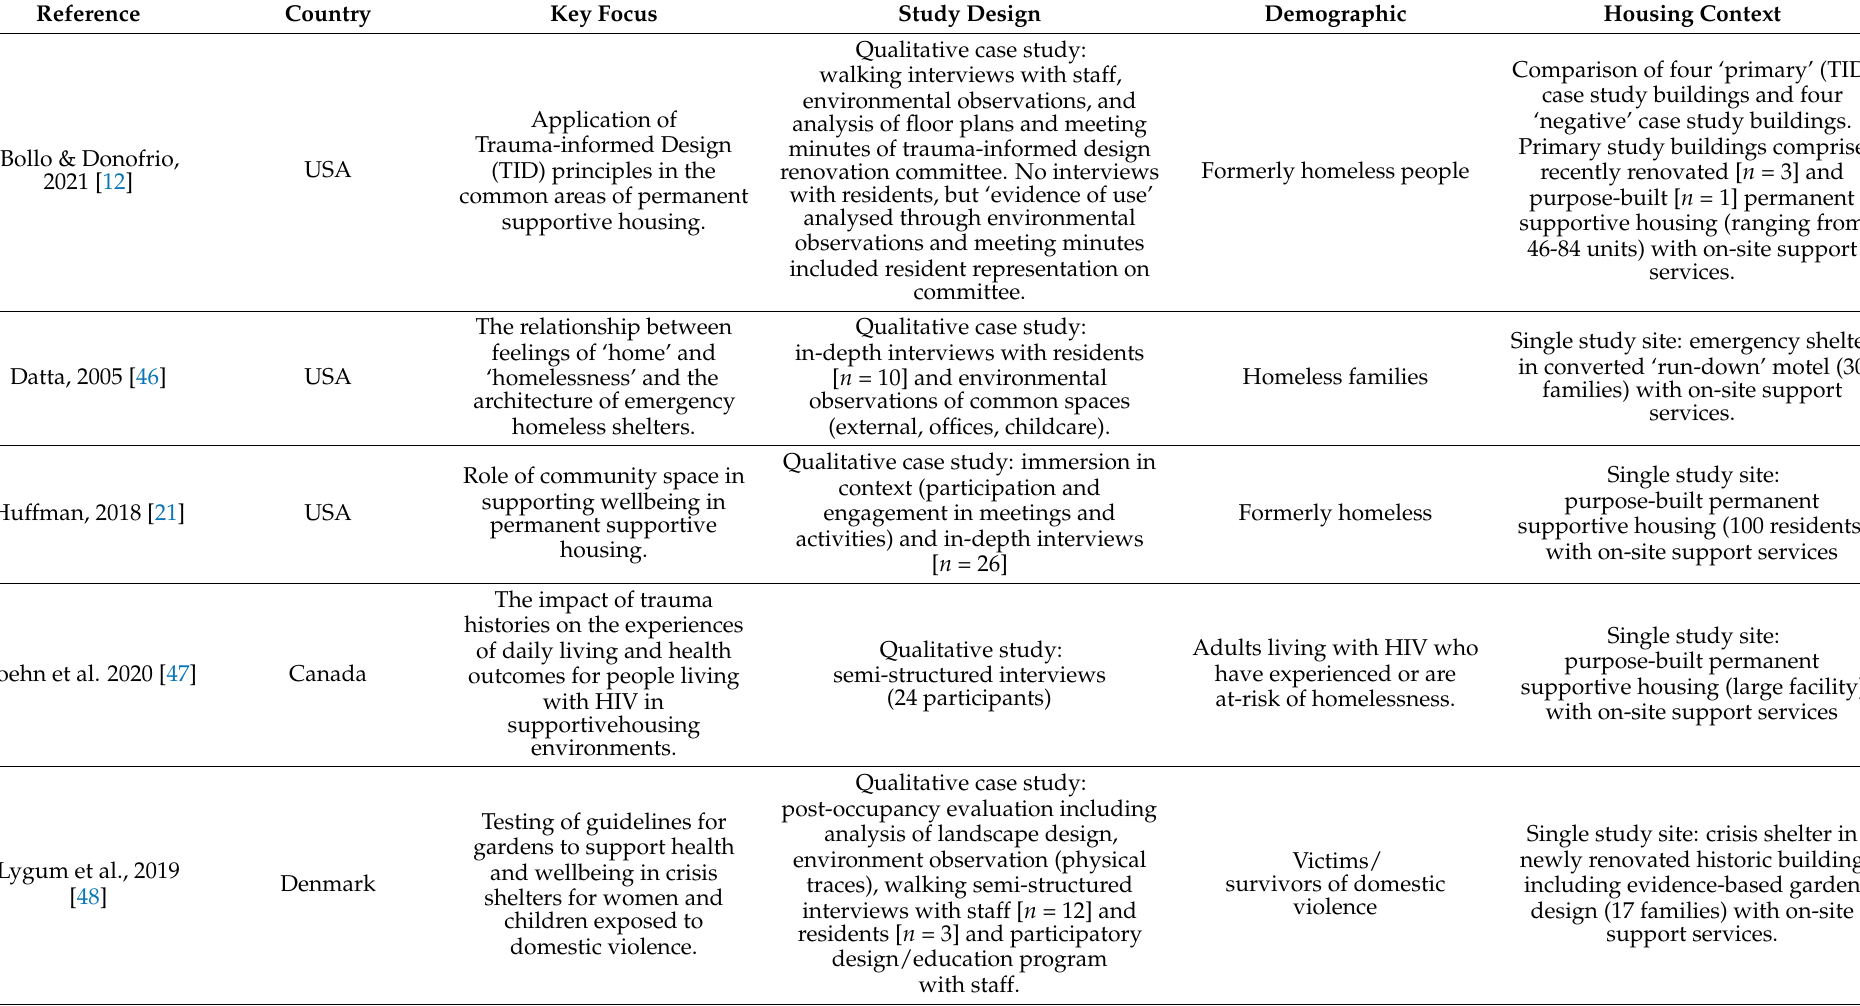
Table 2. Overview of the reviewed